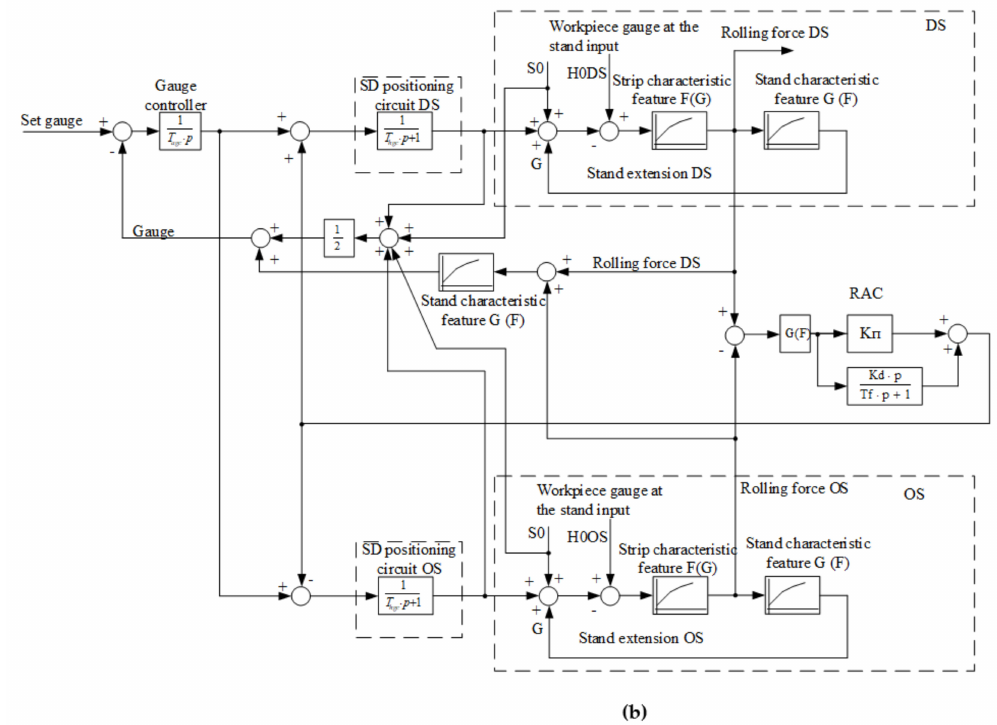
Figure 9. Structural diagram ( a ) and flowchart ( b ) of the model of linked screw-down positioning systems (with a RAC controller).